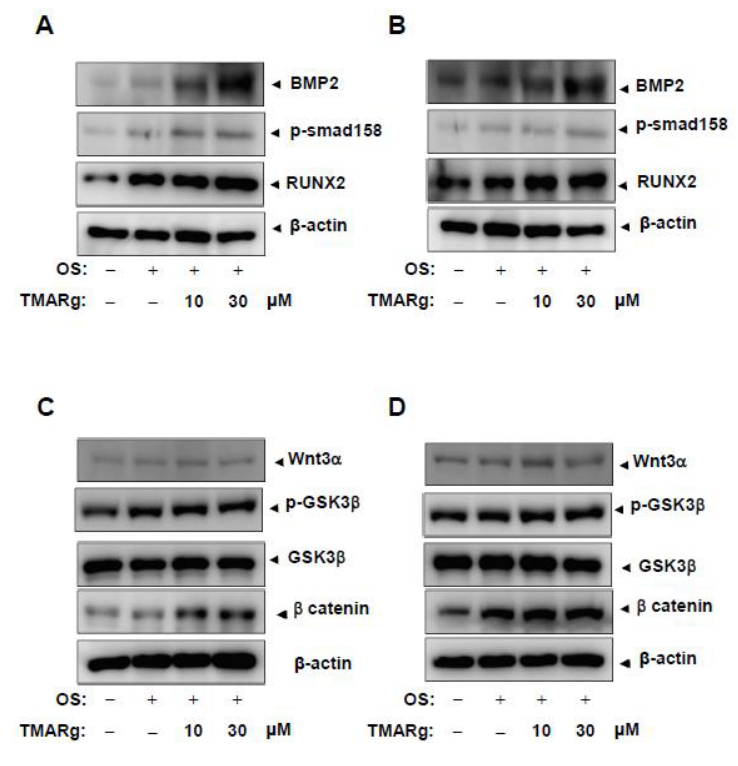
Figure 4. TMARg enhances intracellular BMP2 signaling and β-catenin in osteoblast differentiation.